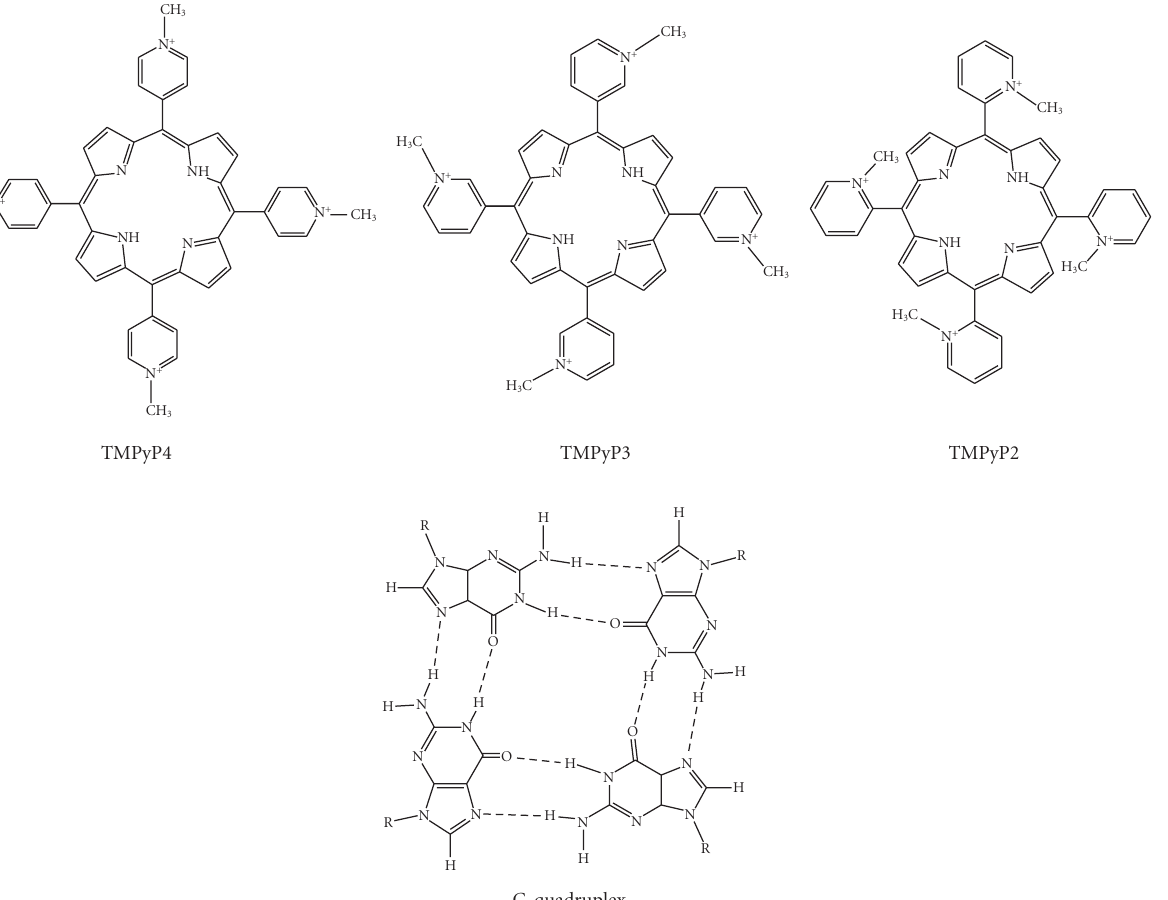
Figure 1: The structures of G-quadruplex DNA and TMPyP2, TMPyP3, and TMPyP4